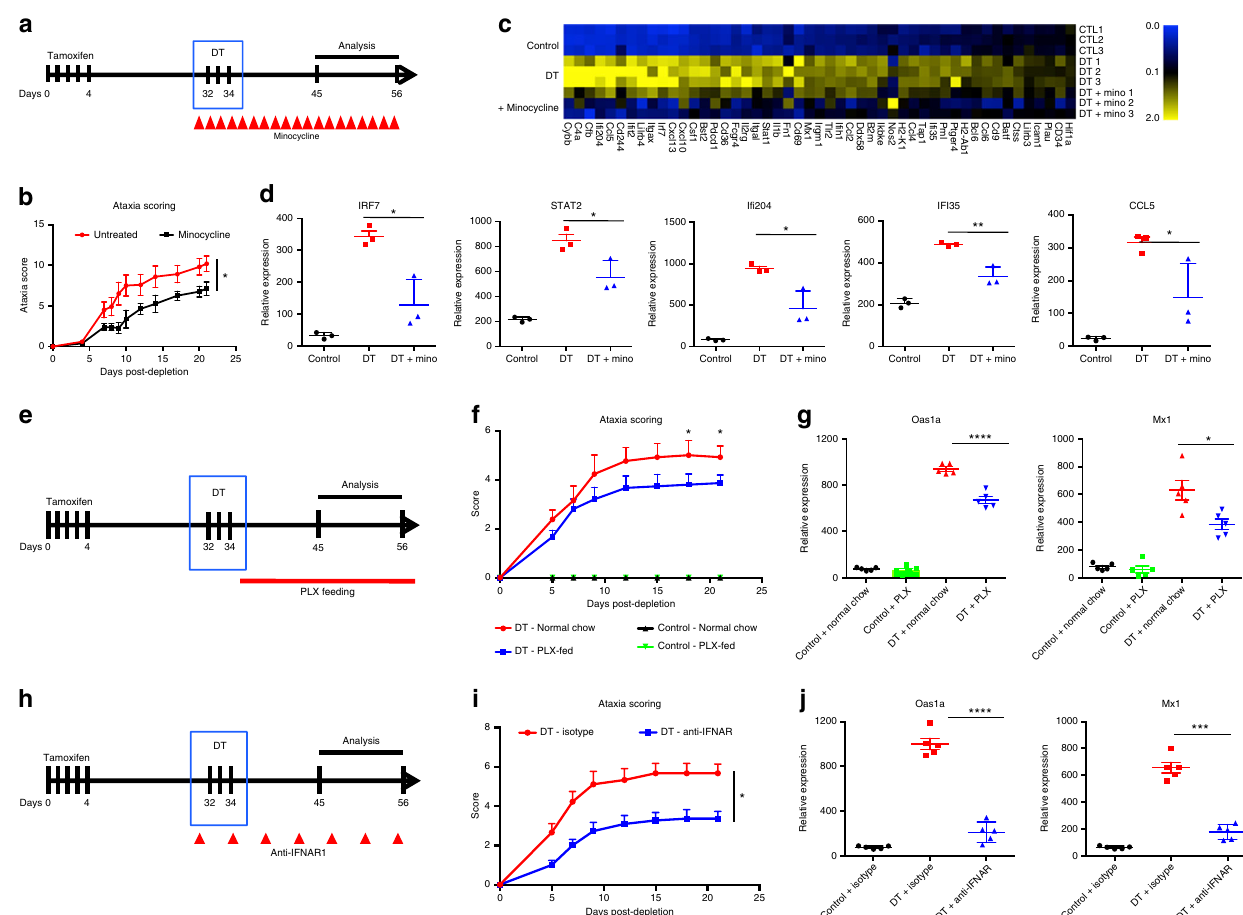
Fig. 5 Blunting type 1 interferon-mediated neuroin fl ammation reverses effects of microglia ablation. a Schematic of minocycline treatment to blunt neuroin fl ammation in microglia-depleted mice. b Ataxia behavior scoring of microglia-depleted mice (red) and minocycline-treated mice (black). c Heatmap depicts upregulated (yellow) and downregulated (blue) genes in microglia from control, d10 microglia-depleted and d10 microglia-depleted mice treated with minocycline analyzed with Nanostring immunology chip. d Dot plots demonstrate the relative expression levels in wild-type control (black), d10 post depletion microglia (red) and d10 microglia-depleted mice treated with minocycline (blue). e Schematic of PLX5562 feeding to prevent microglia repopulation in DT-ablated mice. f Ataxia clinical scoring of DT mice treated with isotype control (red) or anti-IFNAR1 antibody (blue). g Dot plots demonstrate the relative expression levels of the Oas1a and Mx1 in cortical tissue from non-depleted control mice fed control chow (black), control mice fed PLX5562 chow (green), d10 post depletion fed normal chow (red) and d10 post depletion fed PLX chow (blue). h Schematic of anti-IFNAR1 treatment to blunt type 1 interferon signaling in DT-ablated mice. i Ataxia clinical scoring of DT mice treated with isotype control (red) or anti-IFNAR1 treated mice (blue). j Dot plots demonstrate the relative expression levels of the Oas1a and Mx1 in cortical tissue from control (black), d10 + isotype control post depletion (red) and d10 post depletion + anti-IFNAR1 (blue). Representative experiment of two independent experiments. Error bars represent SEM, n = 3 – 5 mice per experiment and dot plots analyzed with unpaired t -test at 95% con fi dence interval, **** p < 0.0001, *** p < 0.001, ** p < 0.01, * p <